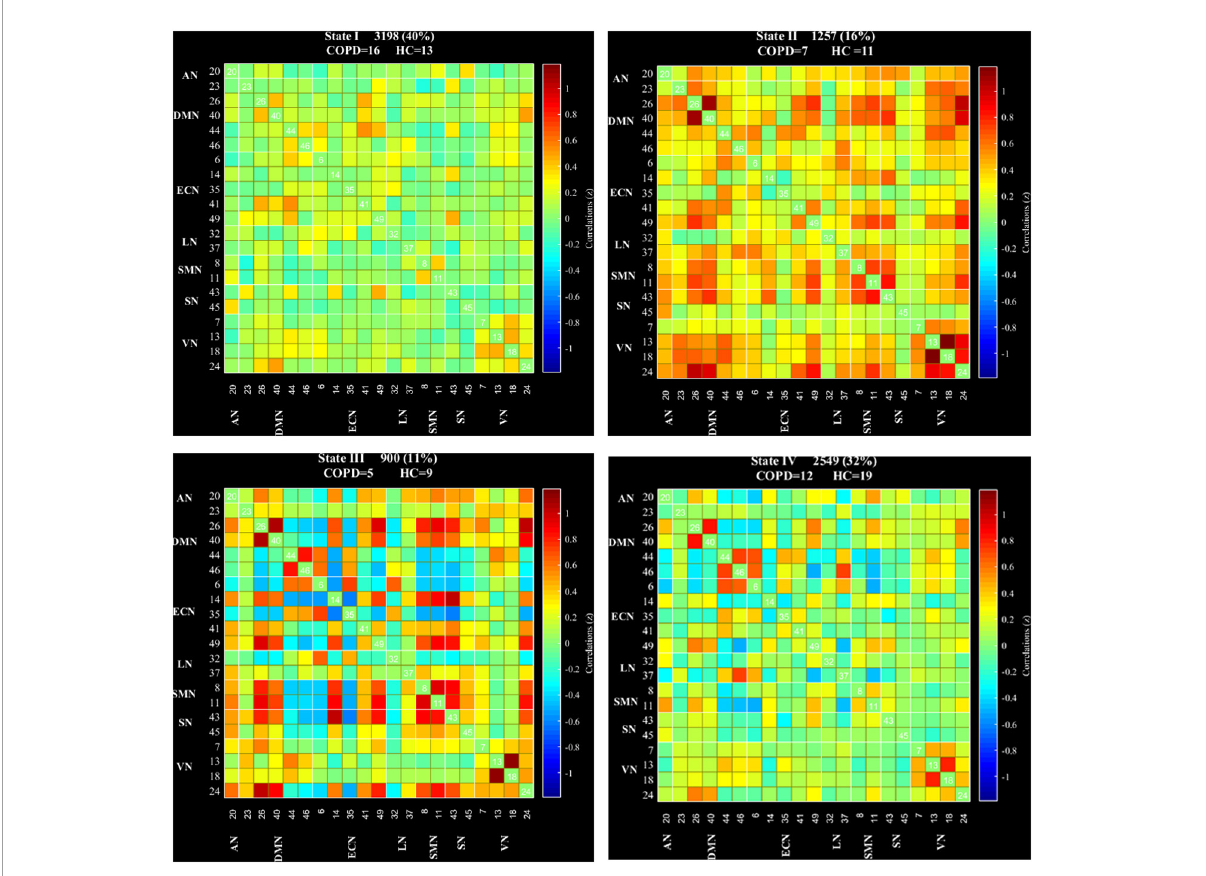
FIGURE3 Dynamic functional network connectivity centroids of four states, the number of subjects, and the percentage of occurrence in each state. AN, auditory network; DMN, default mode network; ECN, executive control network; LN, language network; SMN, sensorimotor network; SN, salience network; VN, visual network; COPD, chronic obstructive pulmonary disease; HC, health controls.